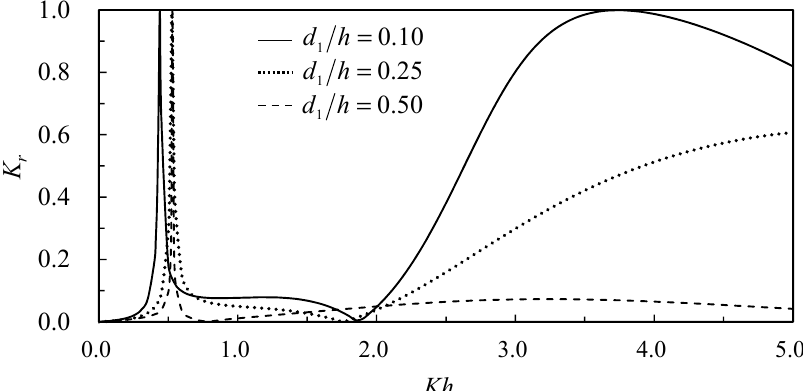
Figure 13. Reflection coefficient versus relative water depth for various submerged depths of the structure ( 𝑑 (cid:2869) / ℎ = 0.10, 0.25,and 0.50 ).